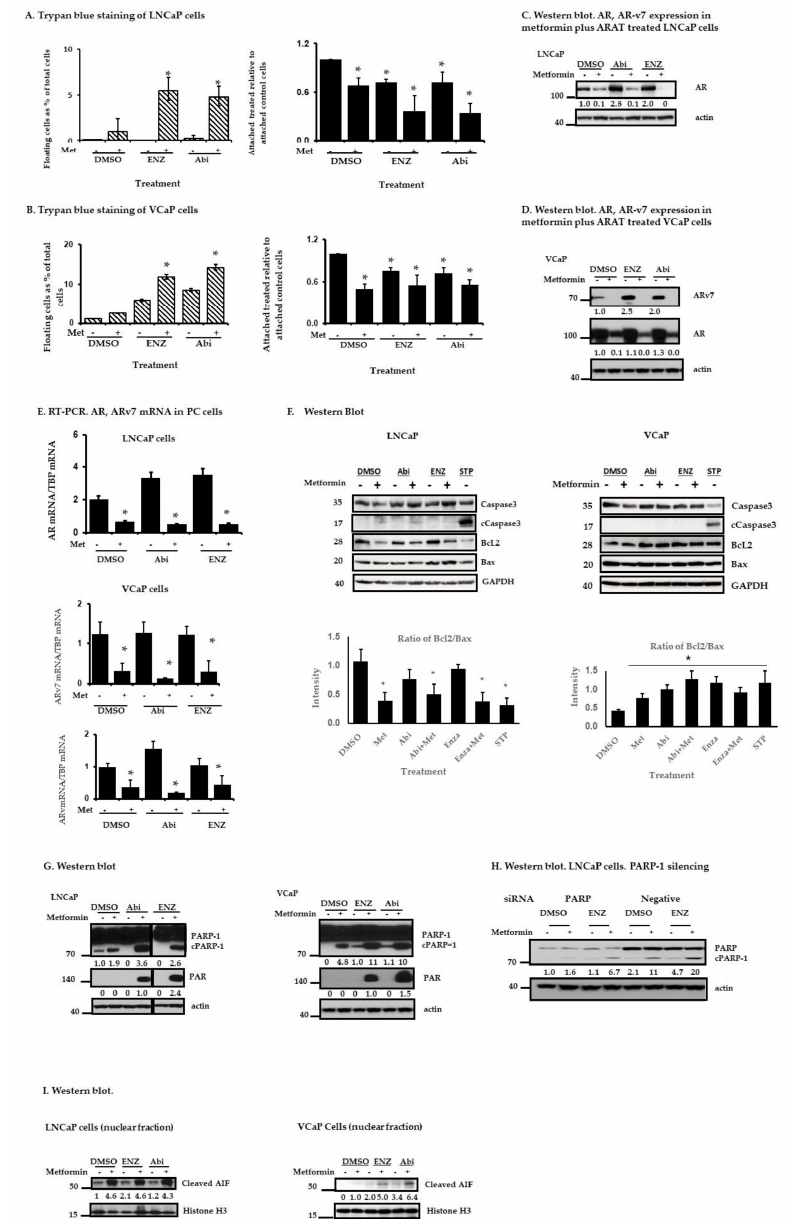
Figure 3. Treatment of PC cells with metformin in combination with ARAT agents (Enz, and Abi). ( A , B ) Trypan blue staining. Cells were treated for 5 days with metformin 1 μ M or Enz (10 μ M) ± metformin or Abi (5 μ M) ± metformin, then stained with trypan blue. Both floating and attached cells were collected. ( A ) Left. LNCaP floating cells shown as a percentage of total treated cells (floating + attached) in each plate. Right. Treated LNCaP attached cells are shown as a fraction of attached control (DMSO-treated) cells (set as 1) ( B ) Left. VCaP floating cells shown as a percentage of total treated cells (floating + attached) in each plate. Right. Treated VCaP attached cells are shown as a fraction of attached control (DMSO-treated) cells (set as 1). Results represent the mean ± S.D. from two separate experiments, each done with triplicate determinations per data point. (* p < 0.05), Student’s t -test. ( C , D ) Western blot. AR, ARv7 expression in PC cells treated for 5 days with metformin, Enz ± metformin, or Abi ± metformin. The Western blots shown are representative of two independent experiments. ( E ) RT-PCR. Relative AR (LNCaP cells) or AR, ARv7 (VCaP cells) mRNA expression in metformin-treated, Enz ± metformin-treated, Abi ± metformin-treated or control (DMSO-treated) cells normalized to TBP mRNA in the respective cells. Results represent the mean ± S.D. from three separate